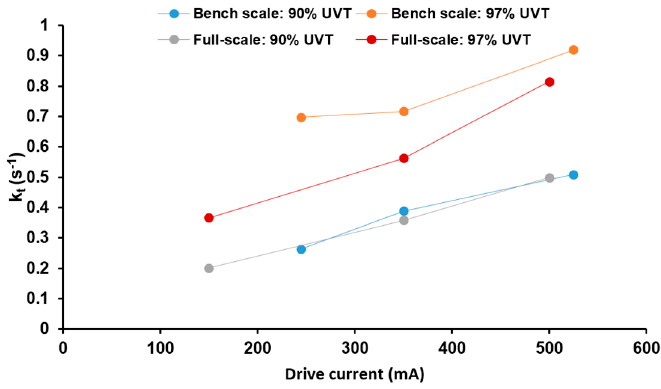
Figure 5. Time-based efficiency against drive current for UV-LED bench- and full-scale reactor.